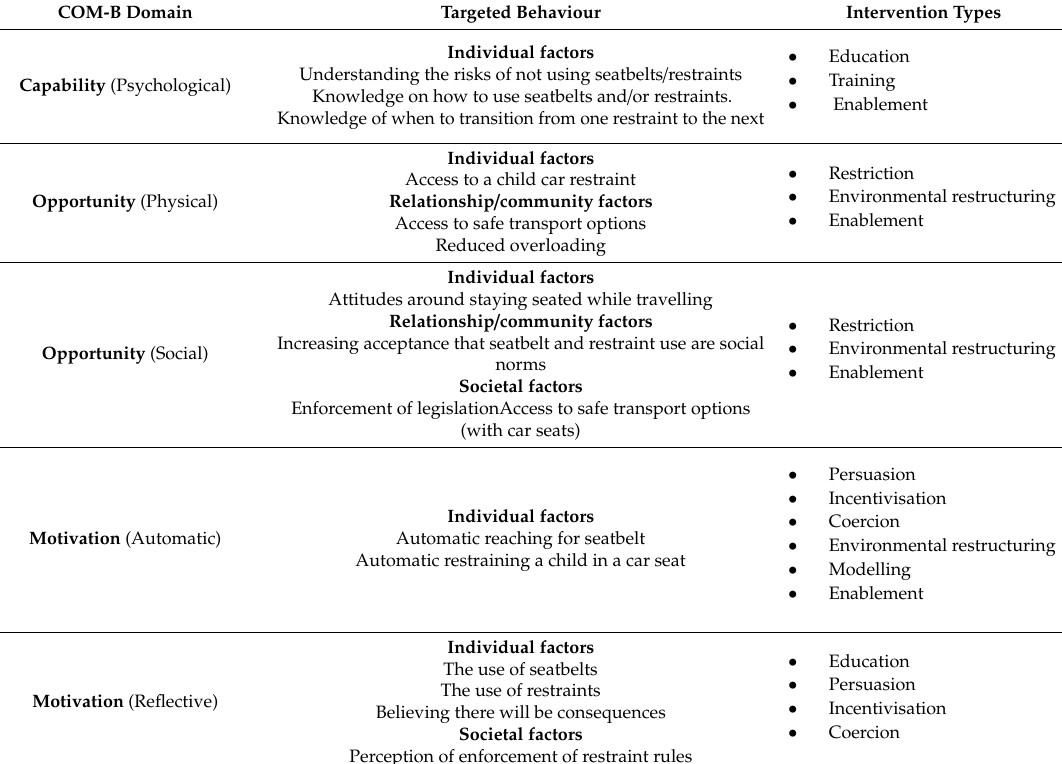
Table 2. The targeted behaviour participants described to increase child restraint use in Cape Town and the intervention types identified as most likely to be impactful by the Behaviour Change Wheel